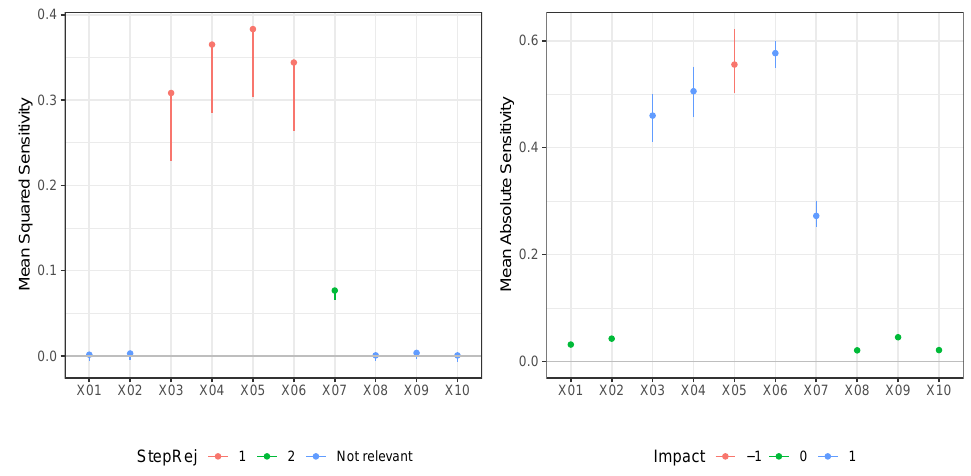
Figure 5. Model M3 (Friedman). Case n = 300. ( left ) Values of test statistic T n and critical values T n − ˆ c ( 1 − α , k ) . ( right ) Values of mean absolute sensitivity along with bootstrap confidence limits with B = 1999 bootstrap replicates and nominal level 1 − α = 0.90 for relevant variables to the